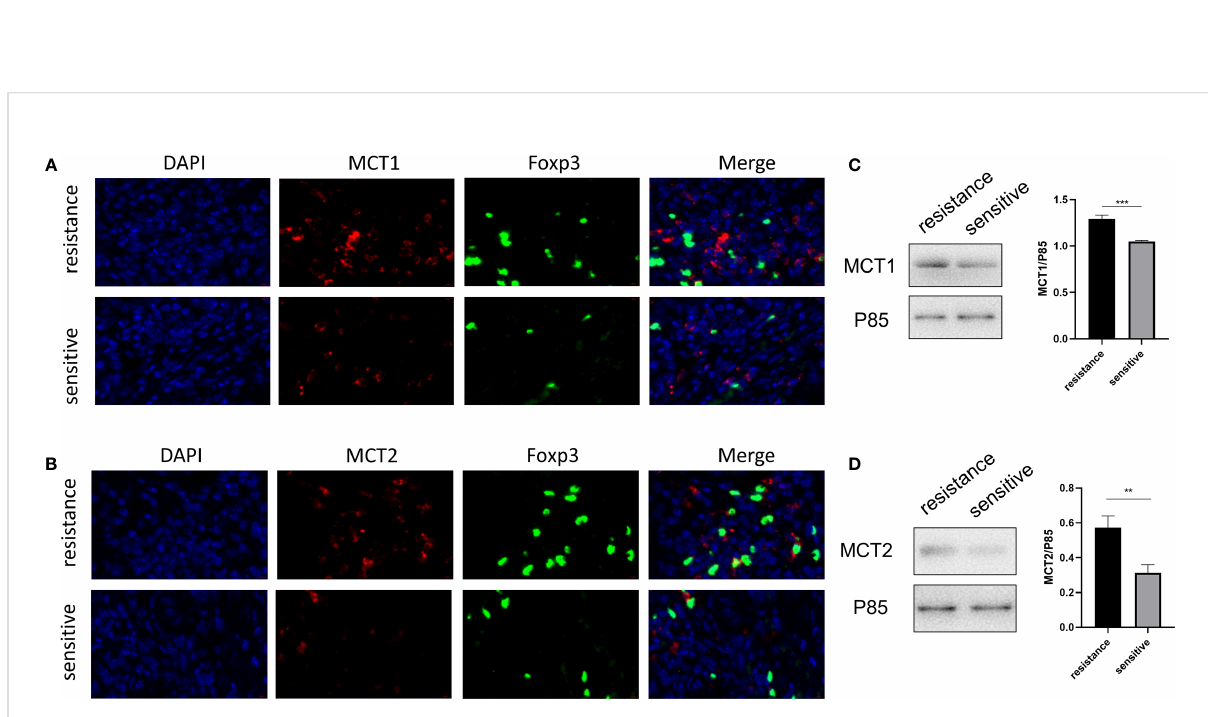
FIGURE 5 Higher MCT1 and MCT2 expression was observed in tumor-in fi ltrating Tregs in resistant patients. Representative plot for expression of MCT1 and MCT2 in Tregs in resected tumor samples from both groups under the confocal microscopy (A, B) and Western blot (C, D) . **p < 0.01; ***P<0.001.